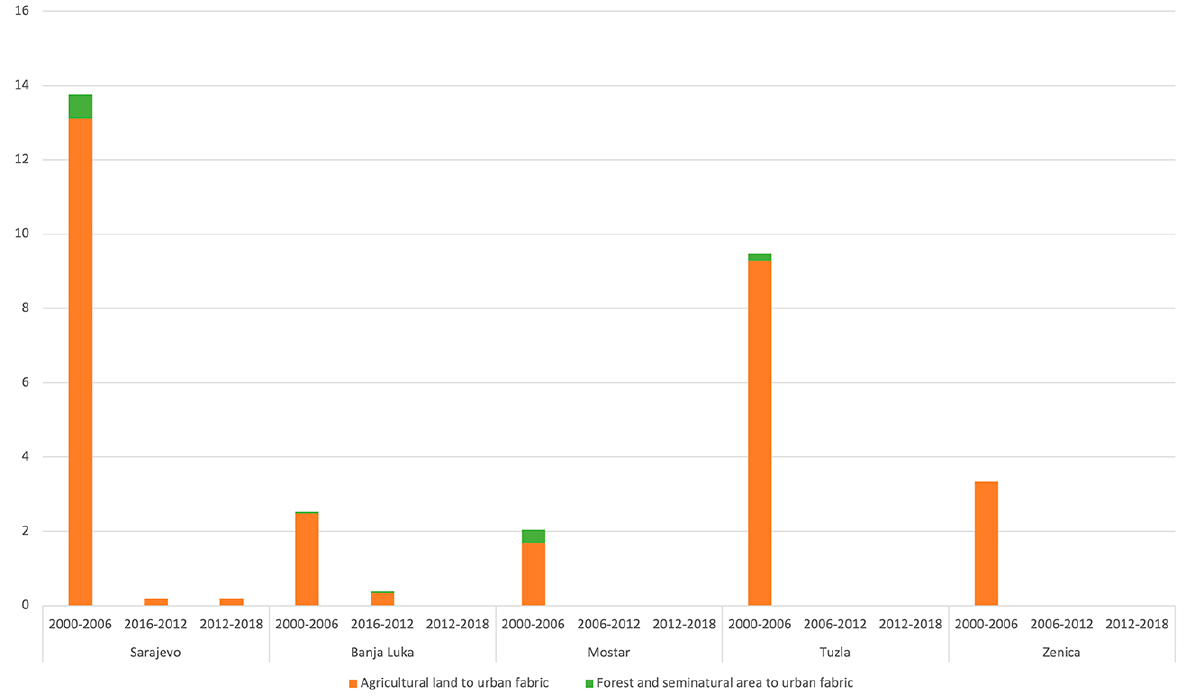
Figure 10. Urban sprawl over other classes according to CLC Changes database (km 2